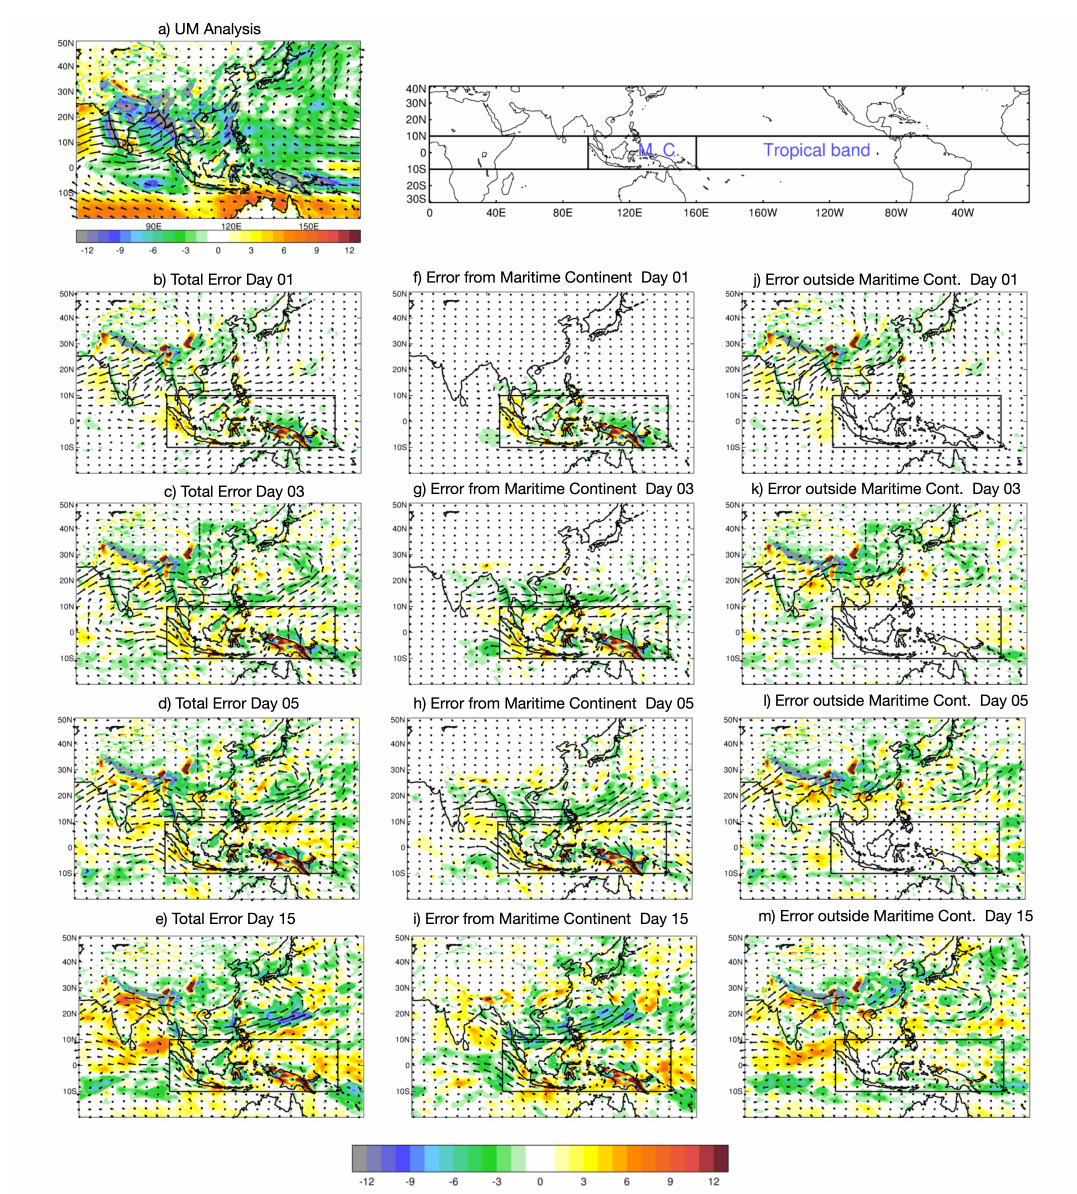
Figure 2. ( a ) June–August 2016 mean atmospheric moisture divergence (shaded, mmday − 1 superimposed to moisture flux vector (arrows) in MetUM analysis; ( b – e ) NWP-N216 total errors of the same quantities, with respect to MetUM analysis, for forecast lead times of 1, 3, 5 and 15 days; ( f – i ) NWP-N216 free run − Maritime Continent nudging, showing errors forced from the Maritime Continent for forecast lead times of 1, 3, 5 and 15 days; ( j – m ) Maritime Continent nudging − global nudging, showing errors forced outside of the Maritime Continent for forecast lead times of 1, 3, 5 and 15 days. To illustrate local versus remote error forcing, the Maritime Continent nudging domain has been drawn in ( f – m